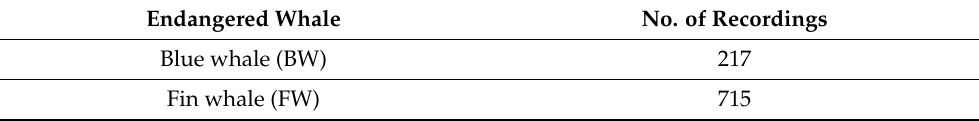
Table 1. The number of sound (wav) files